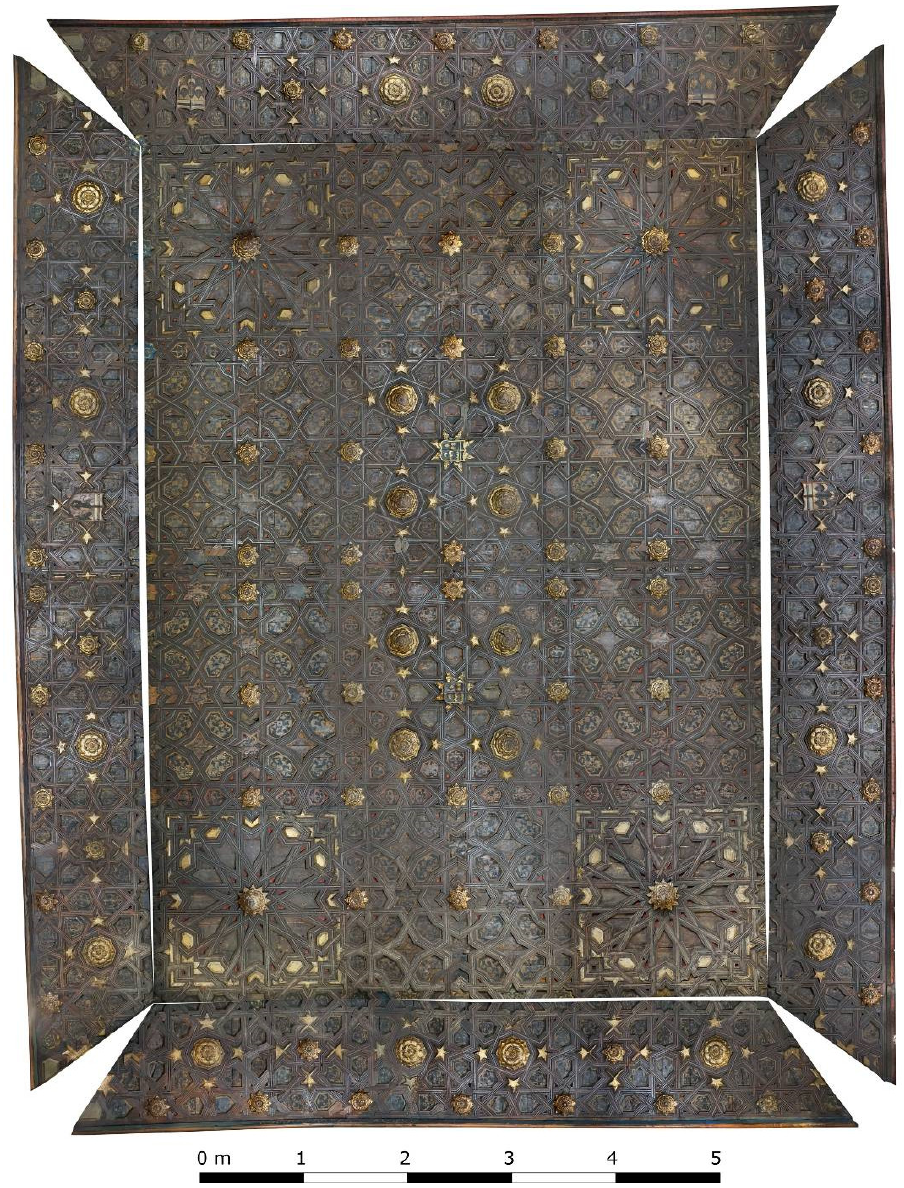
Figure 20. Ceiling orthoimage with the tilted side planes laid flat.